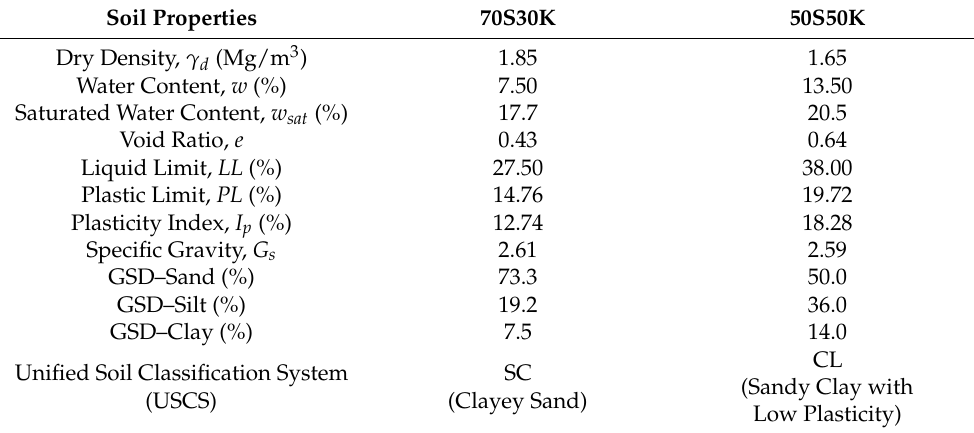
Table 2. Summary of Soil Properties.